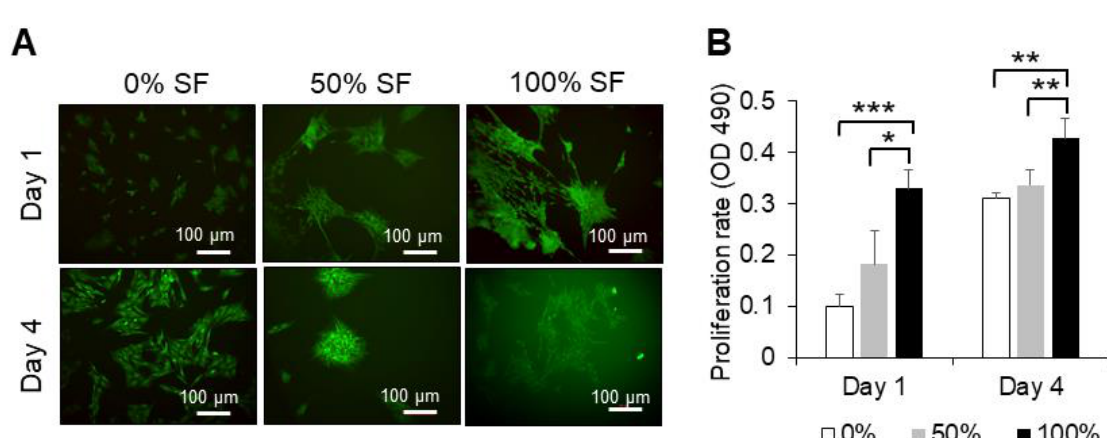
Figure 2. Proliferation rate and calcein staining for viability of BMMSCs co-cultured with autologous synovial fluid. ( A ) Representative BMMSCs after exposure to different concentrations of autologous synovial fluid at days 1 and 4. MSCs were loaded with calcein AM (stains live cells green) and propidium iodide (stains dead cells red). ( B ) Proliferation was evaluated by MTS assay; the absorbance was measured at 490 nm. * p < 0.05, ** p < 0.01 and *** p < 0.001. Quantitative data are expressed as mean ± SD ( n = 3) and were analyzed using one-way ANOVA, with Tukey’s comparison test as a posttest. p < 0.05 was considered statistically significant. One representative experiment is presented from three different experiments using cells from different donors ( n = 3), each performed in triplicate. Scale bars = 100 µm.